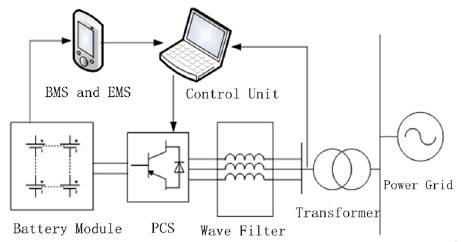
Figure 2. The structure of the battery energy storage system.